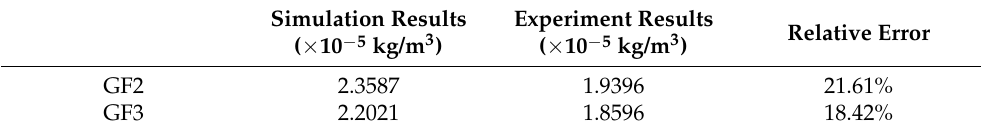
Table 2. Comparison of simulation and experiment